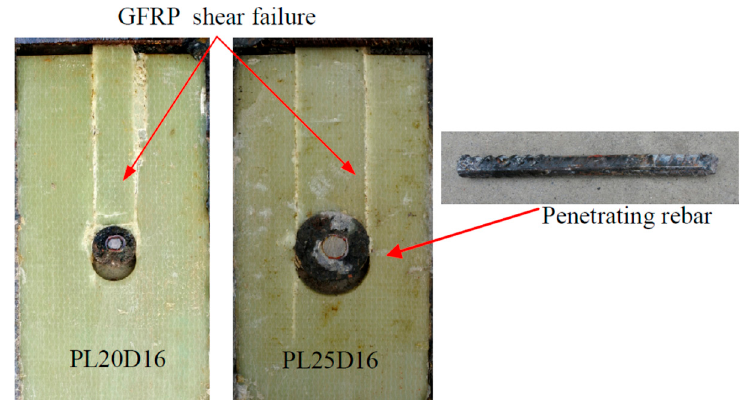
Figure 7. GPC’s failure pattern.